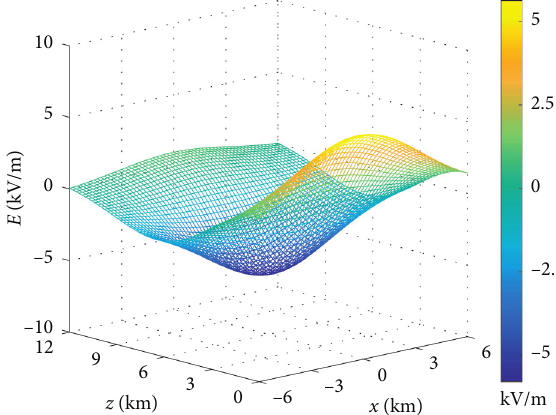
Figure 10: Electric field distribution on the longitudinal section while y � 2000m.